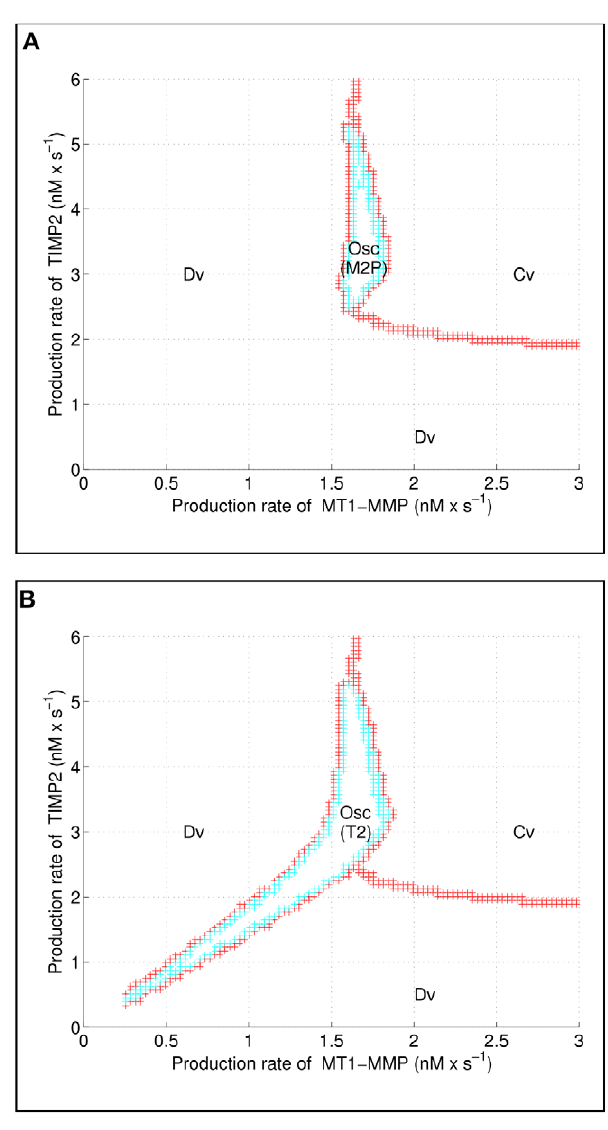
Figure 10. Two maps of different regimes. Region Cv: conver- and all other gence toward a steady state, Region Osc M2P: M P 2 variables oscillate, Region Osc (T2): oscillations of T 2 and other variables for the tail-like part of the region, Region Osc (T2)), but increase of M P 2 . Region Dv: increase of T 2 and M P 2